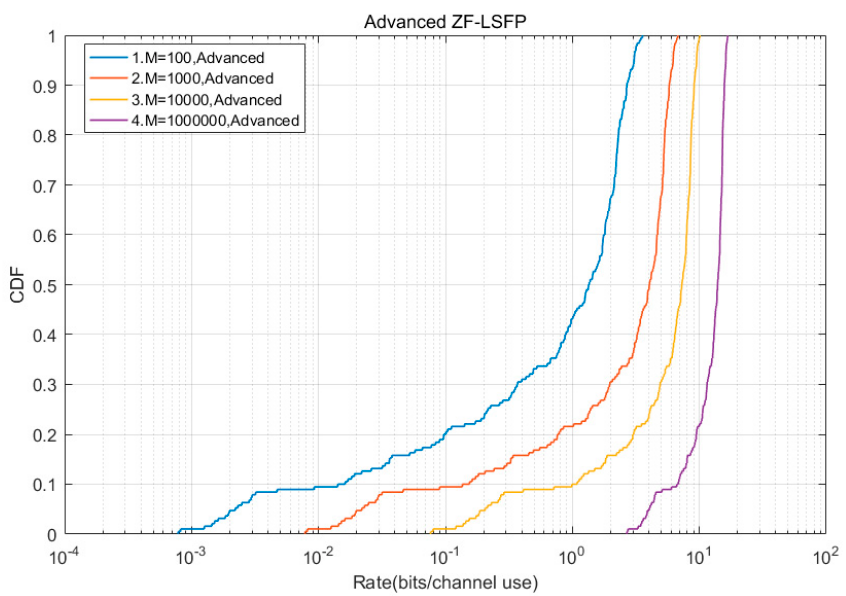
Figure 5. CDF of A-ZF-LSFP channel can achieve transmission rate.